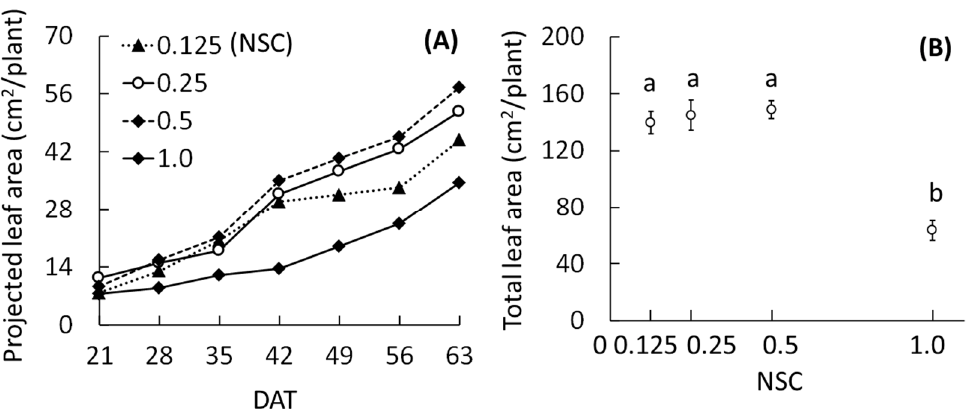
Figure 3. Effects of nutrient solution concentration (NSC) on projected leaf area ( A ) and total leaf area ( B ) of O. pumila in experiment 1. The projected leaf area was measured every week after 21 days after the start of the treatment (DAT), and the total leaf area was measured at 63 DAT. The treatments were 0.125, 0.25, 0.5, and 1.0 NSC. Vertical bars indicate S.E. ( n = 8). Different letters indicate significant differences among the treatments at p < 0.05 by Tukey–Kramer’s test.